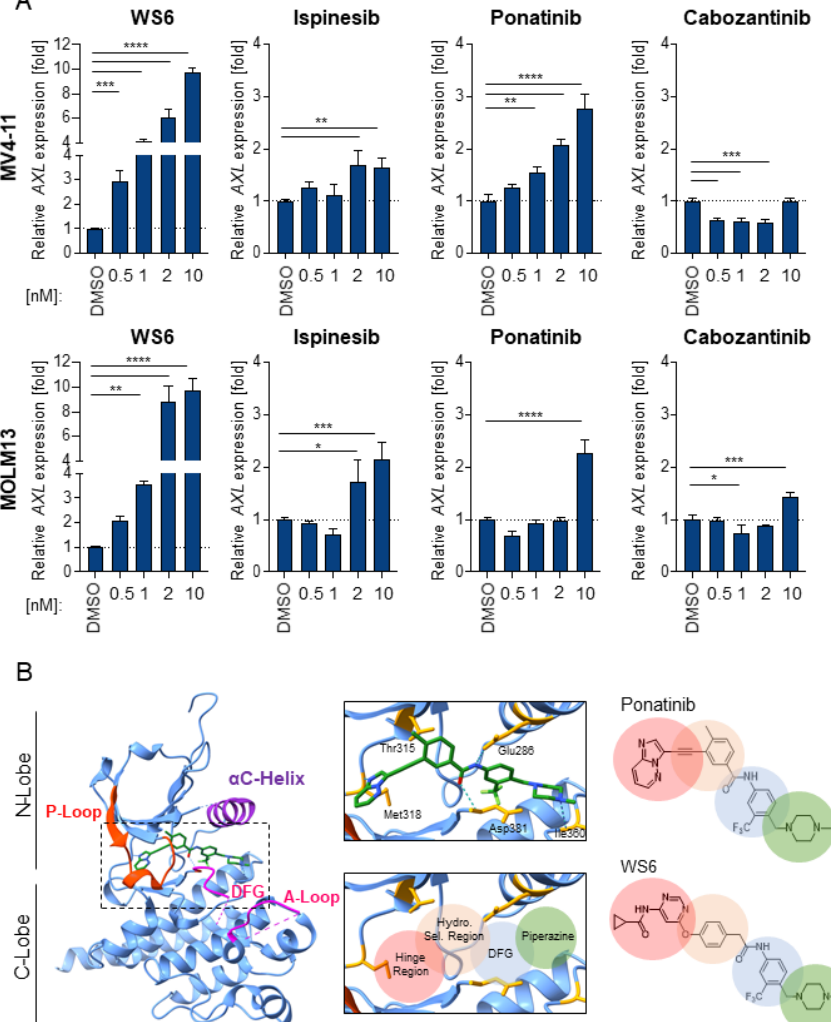
Figure 4. Insights into resistance and apoptosis mechanisms of screened compounds, followed by structural comparison of WS6 and ponatinib. ( A ) MV4-11 and MOLM13 cells were treated with WS6, ispinesib, cabozantinib, or ponatinib at the indicated concentrations for 24 h. Thereafter, AXL gene expression levels were analyzed via RT-qPCR. Cq values were normalized to the housekeeping gene GAPDH. A representative experiment is shown from n = 2. * p < 0.05, ** p < 0.01, *** p < 0.001, **** p < 0.0001. ( B ) Structure of ponatinib (green) bound to the kinase domain of BCR-ABL with key structural motifs labelled (PDB:3OXZ). The inset illustrates a subset of residues responsible for critical binding interactions and H-bonds are shown in blue dotted lines. The shaded circles indicate the regions of interaction that are likely preserved between ponatinib and WS6. Figures were generated with Chimera [31]. To further study the molecular mechanisms of the identified compounds, we investigated the effect of WS6, ispinesib, ponatinib and cabozantinib treatment on the